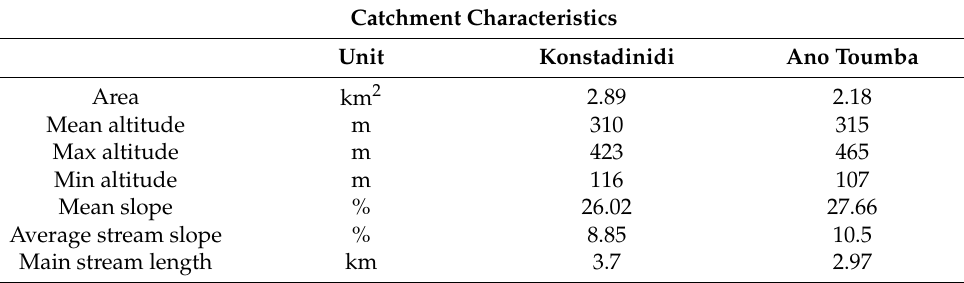
Table 1. Konstadinidi and Ano Toumba morphological characteristics.